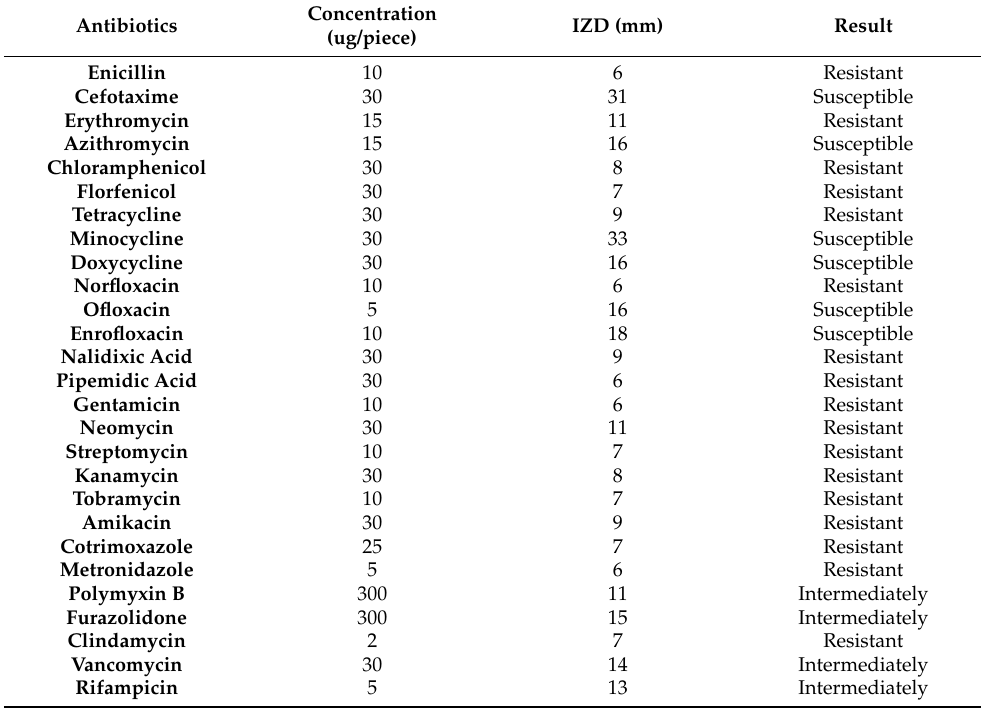
Table 2. Drug sensitivity test.